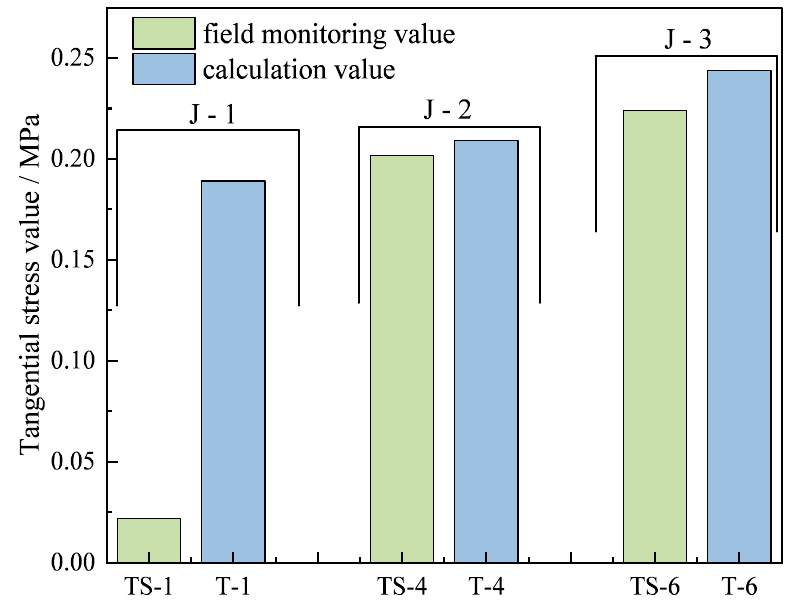
Figure 11. Stress comparison between monitoring value and calculation value.